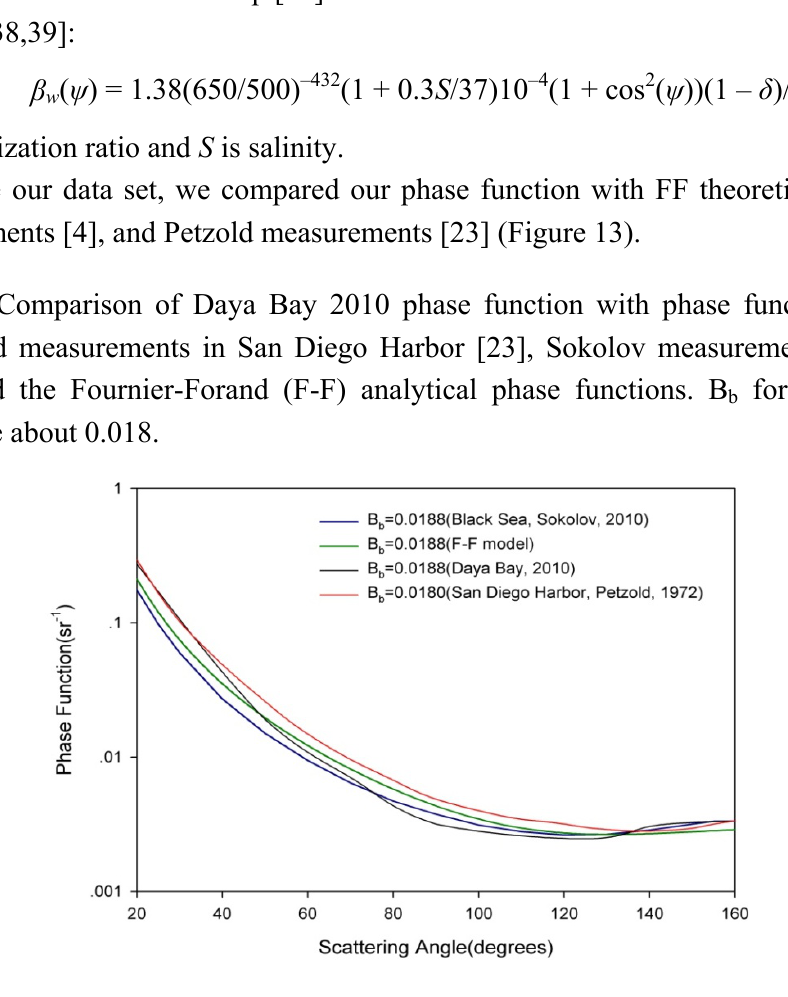
for these phase b